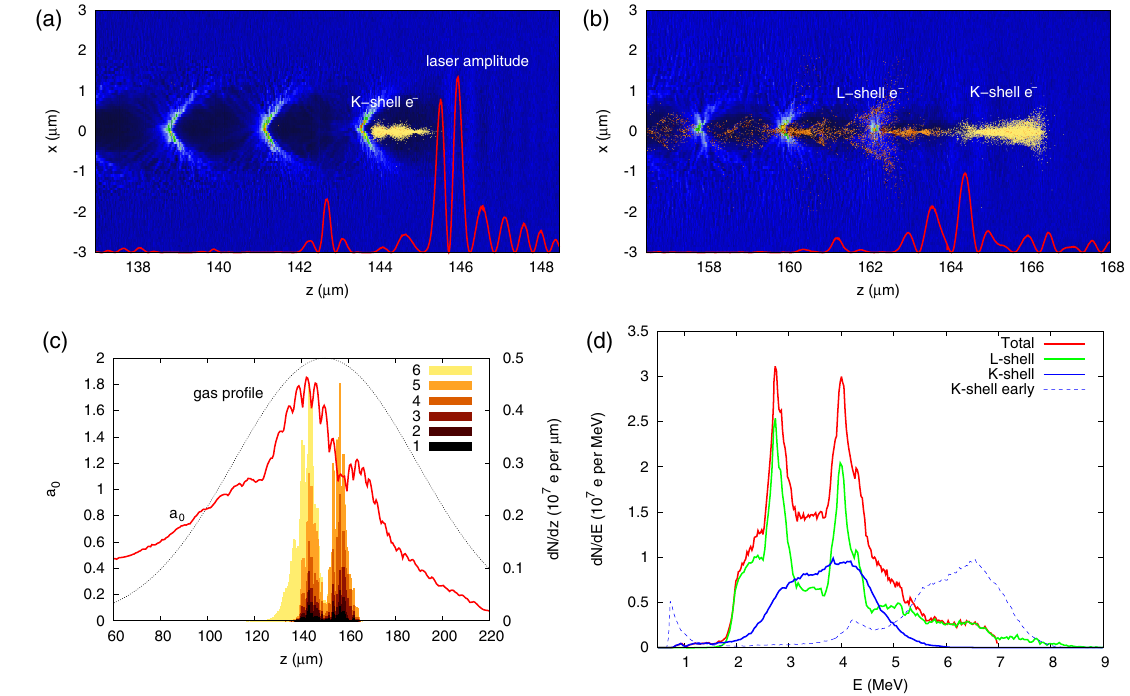
FIG. 5. Results of 3D PIC simulations. (a) and (b) Electron density spatial distribution at two time steps. Trapped electrons are represented by dots. The red curve shows the laser E-field amplitude on the optical axis. (c) Red curve — evolution of the laser normalized amplitude. Histogram — particle trapping locations, decomposed into separate groups based on nitrogen ionization levels from which they originate. For example, electrons marked by “ 1 ” originate from ionization of N 0 , electrons “ 6 ” stem from ionization of N 5 þ , etc. (d) Final electron spectra of K-shell electrons ( “ 6 ” ), L-shell electrons ( “ 1 ” – “ 5 ” ) and a sum of both. An early spectrum of K-shell electrons when the laser is around the middle of the gas jet is shown by the dashed